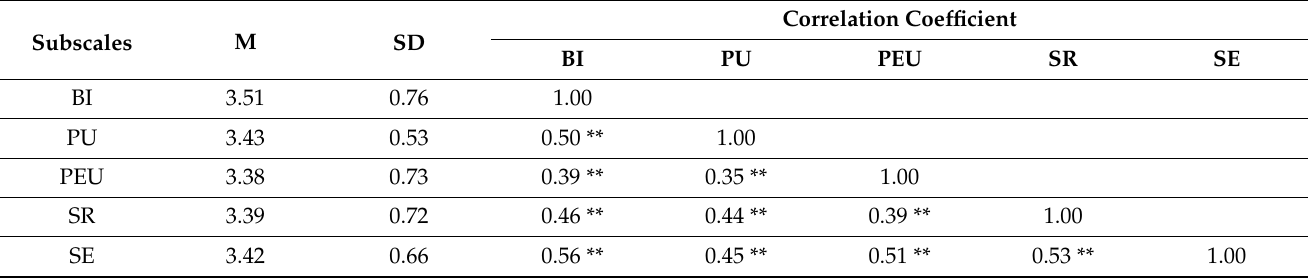
Table 3. Descriptive statistics and correlation coefficients among